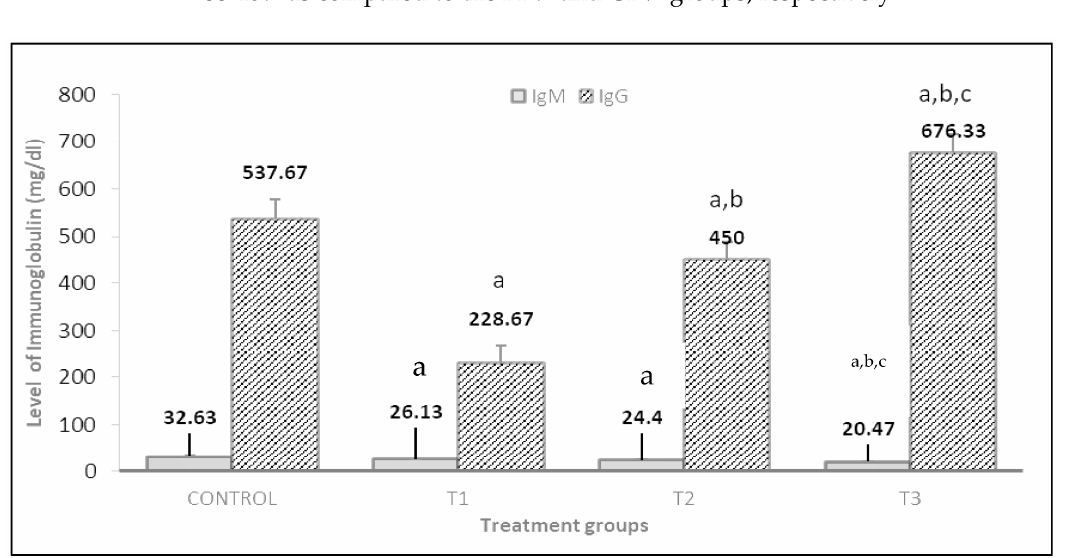
Figure 9. Effect of pomegranate peel and garlic powder separately or in combination on serum pro- lactin and progesterone levels of does. Values are presented as means ± SE (n = 5 litters). T1; pome- granate peel 3%, T2; garlic 3%, and T3; pomegranate peel 1.5% + garlic 1.5%. a Significant difference as compared to control, b Significant differences as compared to T1 ( p < 0.05).